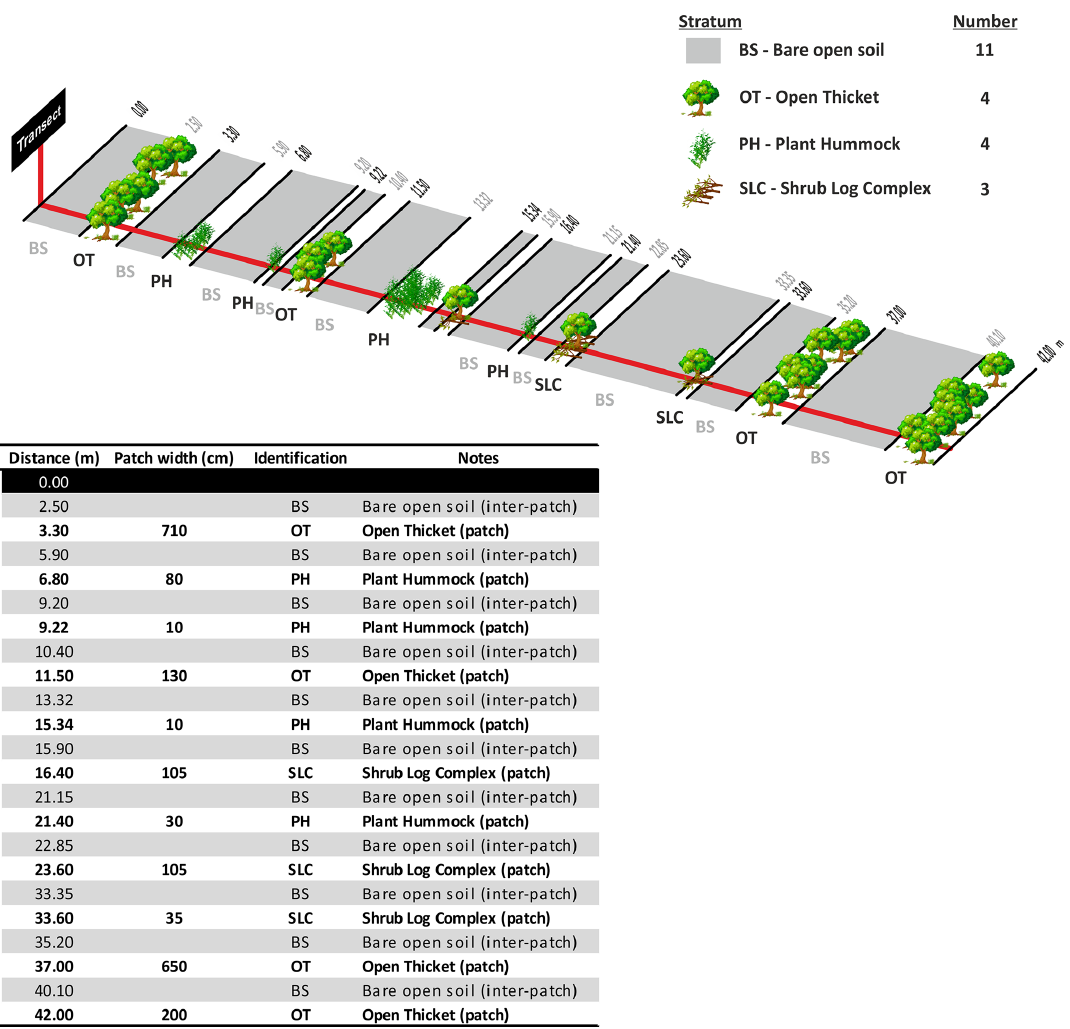
Figure 8. Illustrated example of a transect and its information once recorded in the field data sheet. Redrawn from Tongway and Hind- ley